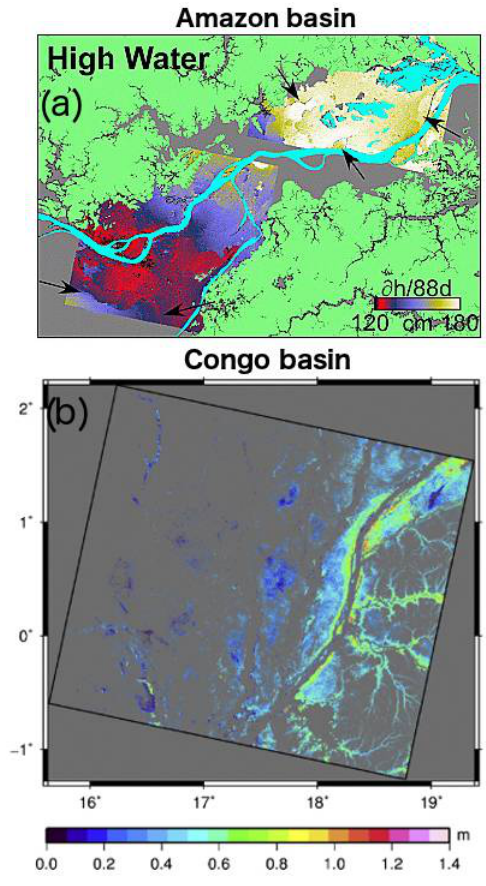
Figure 1. ( a ) Spatial patterns of temporal water-level changes over the Amazon as measured from interferometric SAR (InSAR) between 15 April and 12 July (88 days in 1996, during the “high-water” season). Light green indicates non-flooded, upland forests, gray marks floodplain areas for which no interferograms were available, light blue shows main rivers and permanent lakes which did not yield an interferometric measure of water-level changes, and arrows indicate locations of sharp changes in water-level changes. Temporal water-level changes over the period ranged from 120 cm (red) to 180 cm (ivory). Reprinted with permission from [110] 2007 John Wiley and Sons. ( b ) Map of water depth beneath the flooded forest of the Central Congo River basin inside the PALSAR ScanSAR coverage in December 2008. Gray areas are regions classified as non-flooded or main river channels where interferometric measures of water-level changes were not available. Water depth ranged from a few centimeters (dark blue) to 1.4 m (light pink). Reprinted with permission from [113] 2015 Elsevier.